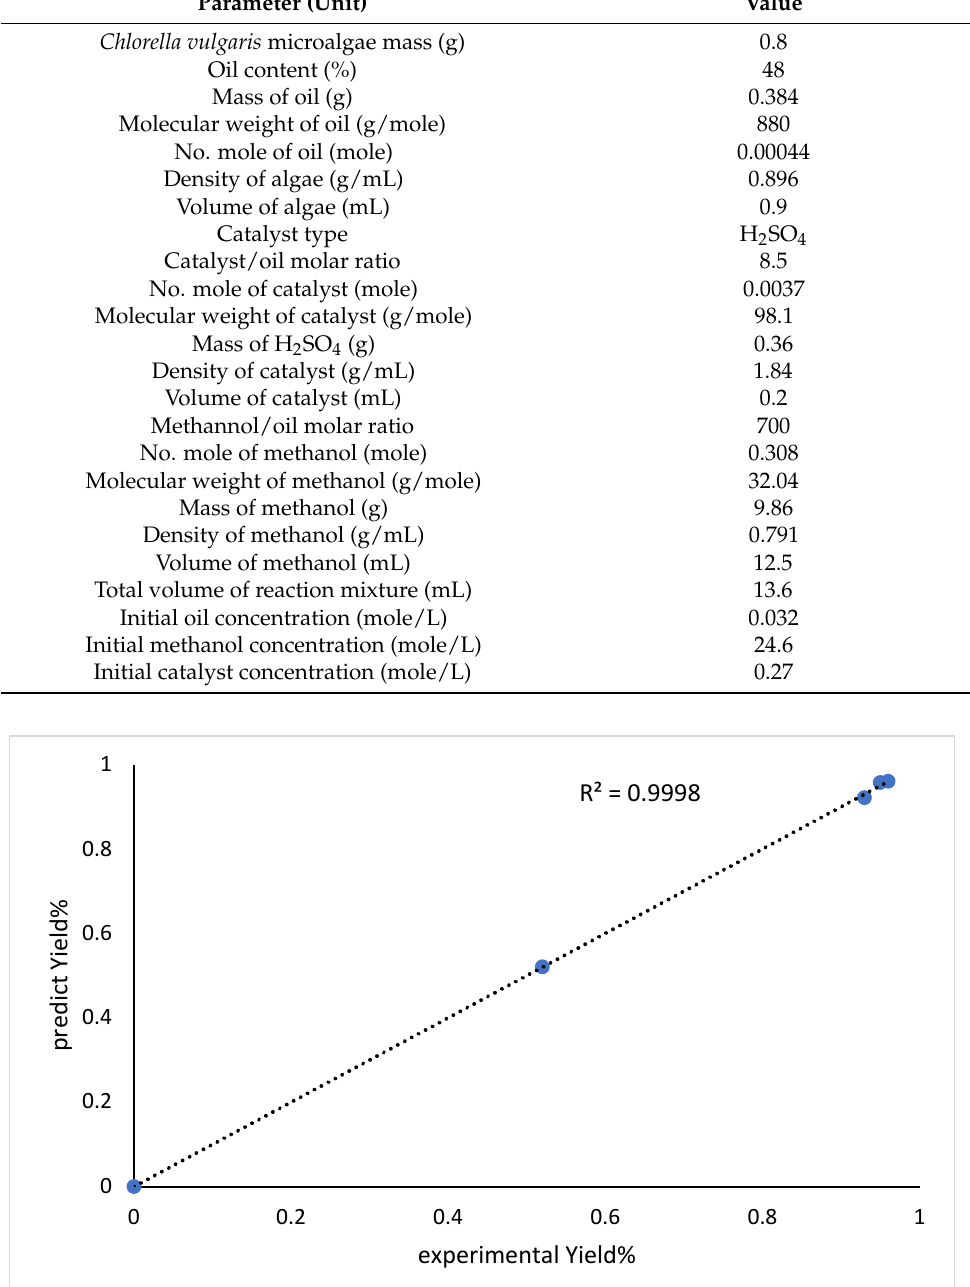
Table 2. Calculation of data required for kinetic investigation.